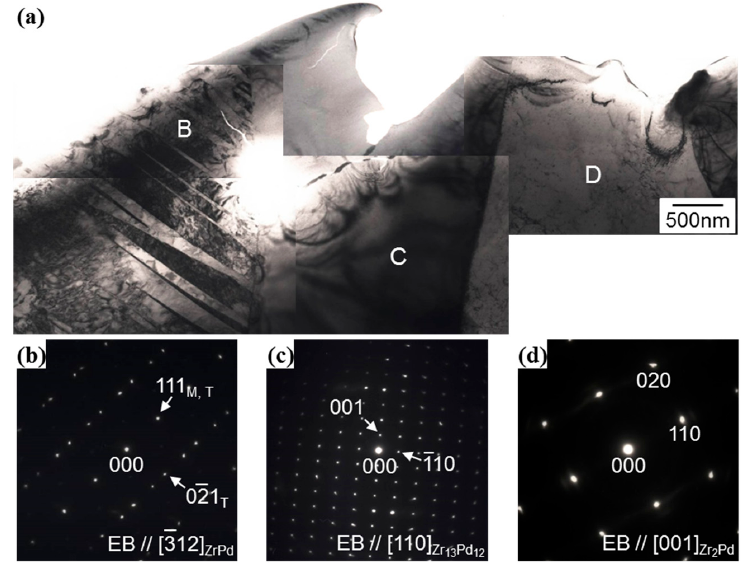
Figure 11. ( a ) Bright field image of Zr-48.0 atom % Pd alloy aged at 1098 K for 720 ks. ( b – d ) Electron diffraction patterns taken from the areas marked B, C, and D in ( a ), respectively. These patterns can be indexed consistently with ZrPd, Zr 13 Pd 12 , and Zr 2 Pd phases, respectively.